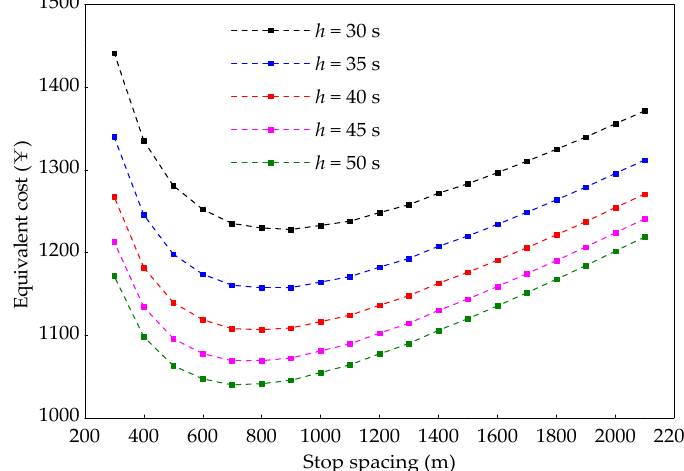
Figure 5. Equivalent cost versus stop spacing with different BRT headways.